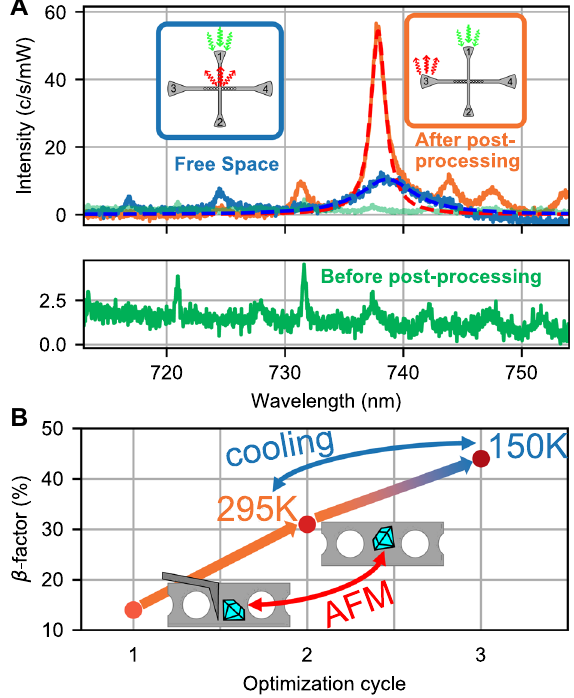
Figure 3: Optimized emitter-cavity coupling. A The cross-talk spectrum of the cavity (green) before the ND was placed, shows a resonance at 737.4 nm. In blue the free space emission of the SiV − ensemble for ≈ 150 K. The free space emission was collected in the center, while excited over port 1, as it can be seen in the small inset. Thespectrumofthecoupledcavityemissioninorangeshowsaclear magni fi cation of the emission rate for the resonance at 737.9 nm (excited over port 1 and collected from port 3). A β -factor of 0.44